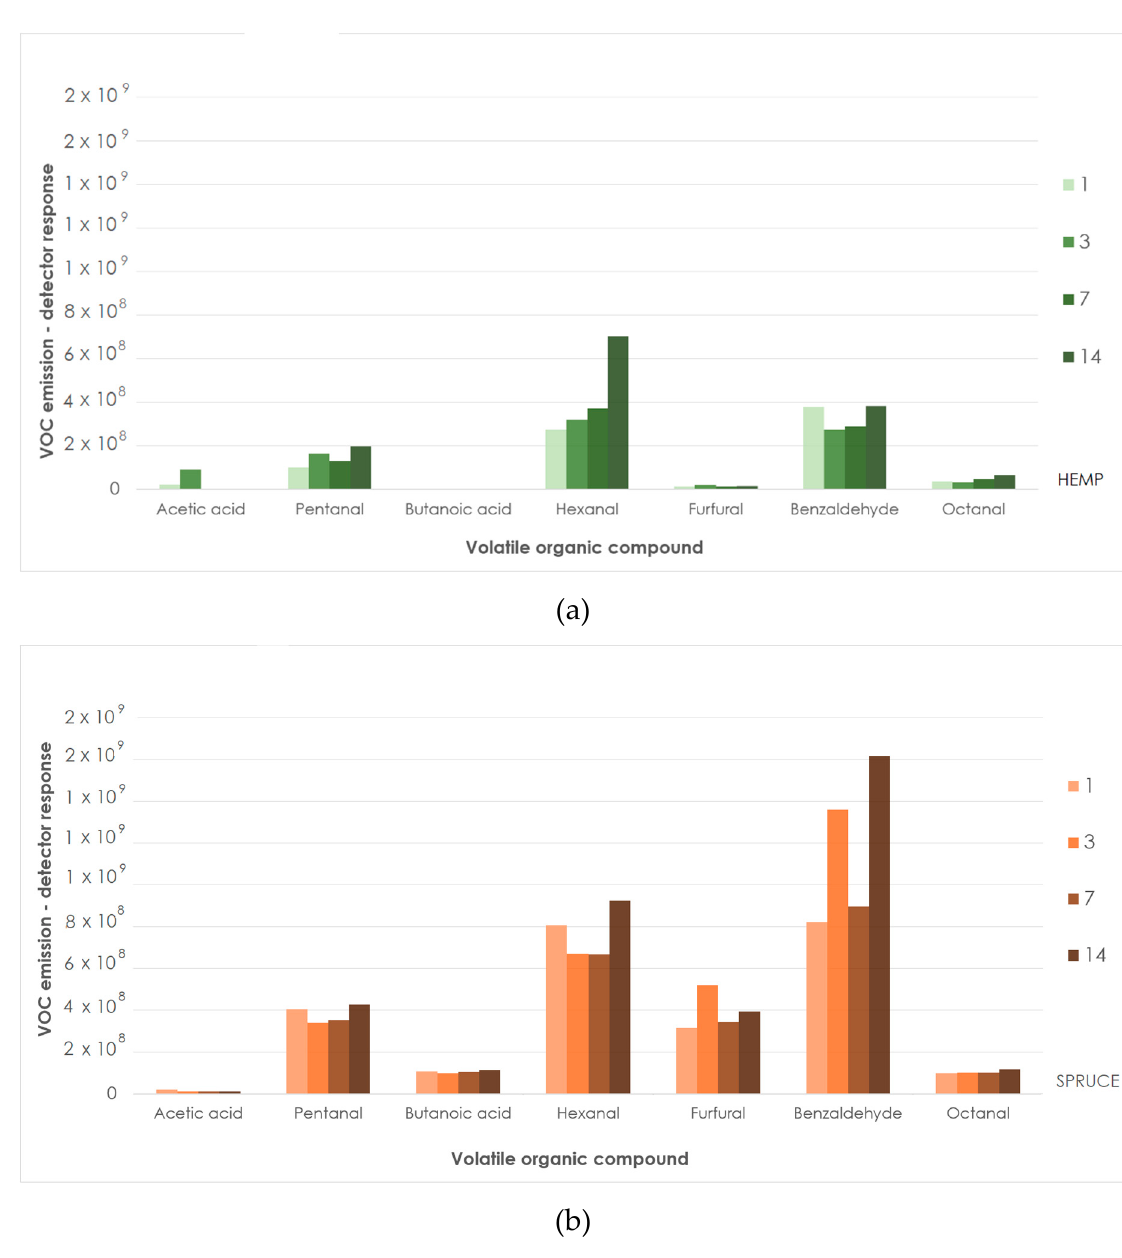
Figure 2. Selected VOC emissions from spruce wood and untreated hemp (day 1, 3, 7, 14; detector response for unique mass) ( a ): untreated hemp shive; ( b ): spruce strands.